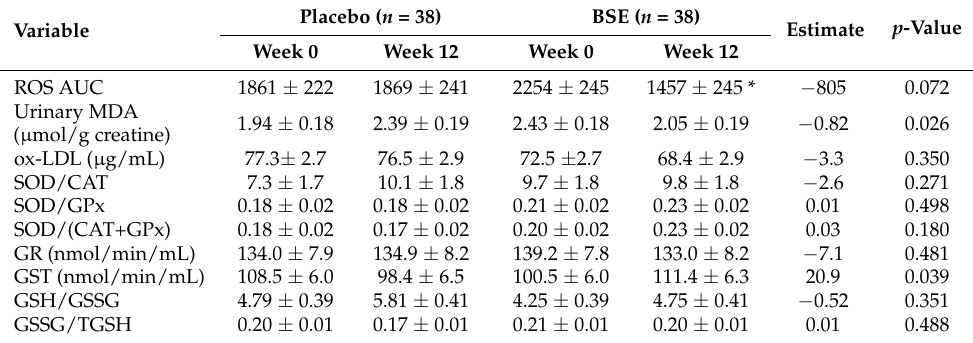
Table 2. Oxidative stress markers and antioxidant levels at the baseline and endpoint in the placebo and BSE